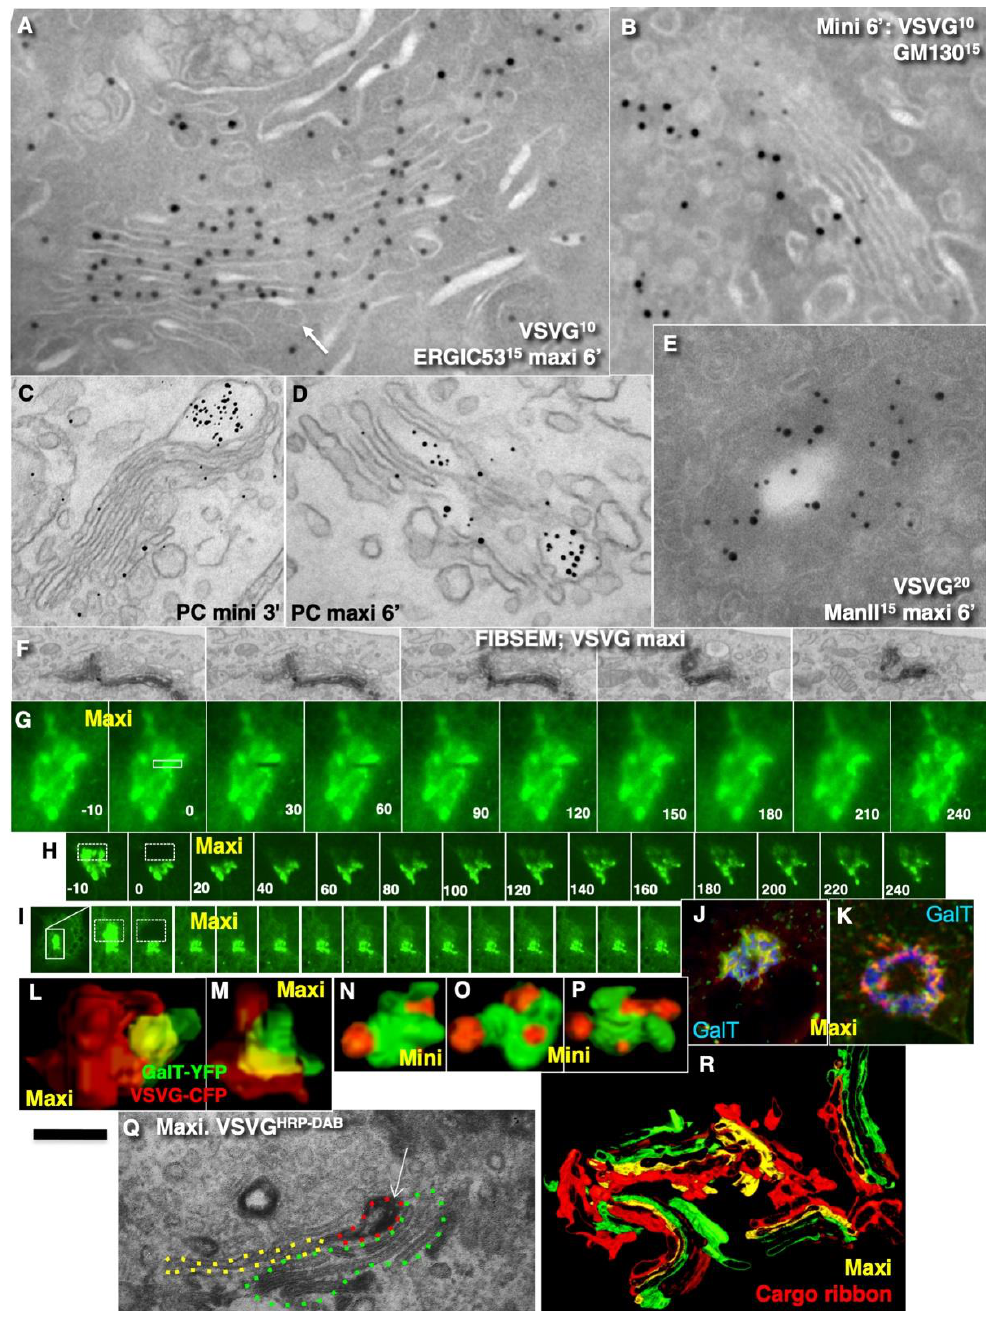
Figure 13. The pattern of intra-Golgi transport depends on the amount of cargo transported. ( A , B , E – R ) Hela cells. ( C , D ) Human fibroblasts. Protocols of cargo synchronisation are shown in images, as the mini-wave ( B , C , N – P ) and the maxi-wave ( A , D , E , F , G – M , Q , R ). ( A , B , E ) Tokuyasu cryo-sections. HeLa cells were transfected with VSVG-GFP (10-nm gold immunolabelling) and subjected to the maxi-wave and mini-wave protocols of cargo synchronisation. When a large amount of VSVG-GFP was transported ( A ), this cargo penetrated up to the trans-most cisterna (white arrow). Intermixing of VSVG-GFP and ManII was higher than after the mini-wave (( E ); compare with Figure 6C). During the mini-wave ( B ), the penetration of VSVG was lower (quantified in Figure 7G – H). ( C , D ) Enhanced nanogold. Human fibroblasts were stimulated to synthesise PCI and then subjected to the mini-wave ( C ) and maxi-wave ( D ) protocols of PCI synchronisation. During the maxi-wave, the penetration of PCI was deeper (quantified in Figure 7E,F). ( F ) Focused ion beam scanning EM (FIBSEM) analysis. Serial images show that the immune – EM labelling for VSVG – GFP is not interrupted and forms a ribbon. ( G – I ) Fluorescence recovery after photobleaching (FRAP). HeLa cells were transfected with VSVG – GFP and then subjected to the maxi-wave protocol (see Methods). Then, the